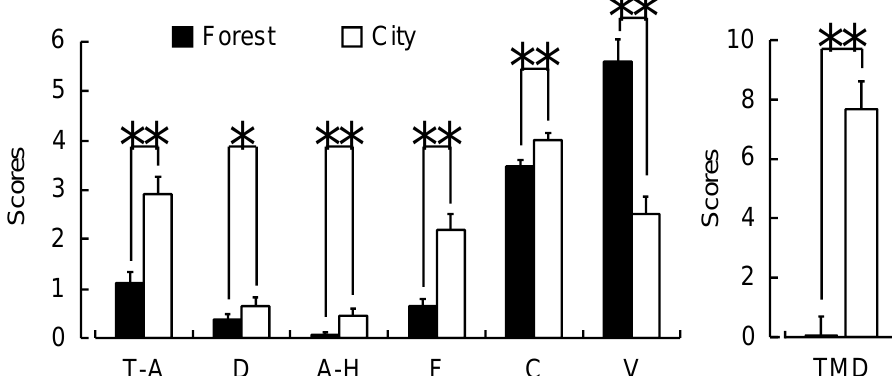
Figure 6. Subjective feelings as measured by the six subscales and the total mood disturbance (TMD) score of the Profile of Mood States questionnaire after walking through forest and city areas. Data are shown as means ± standard deviation (n = 60). ** p < 0.01, * p < 0.05, Wilcoxon signed-rank test (one-sided). T–A, tension and anxiety; D, depression and dejection; A–H, anger and hostility; F, fatigue; C, confusion; V, vigor.